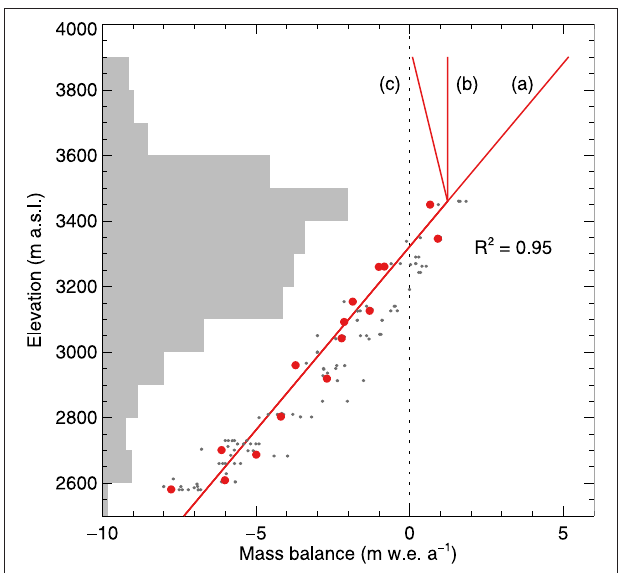
FIGURE 3 | Elevation distribution of mass balance measurements on Findelengletscher in 2012 (red dots) and all other years (gray dots). Red lines show model functions of elevation used for the profile method and (a) linear, (b) constant, and (c) inverted gradients above 3460 ma.s.l. . Gray horizontal bars show the area-elevation distribution of Findelengletscher.